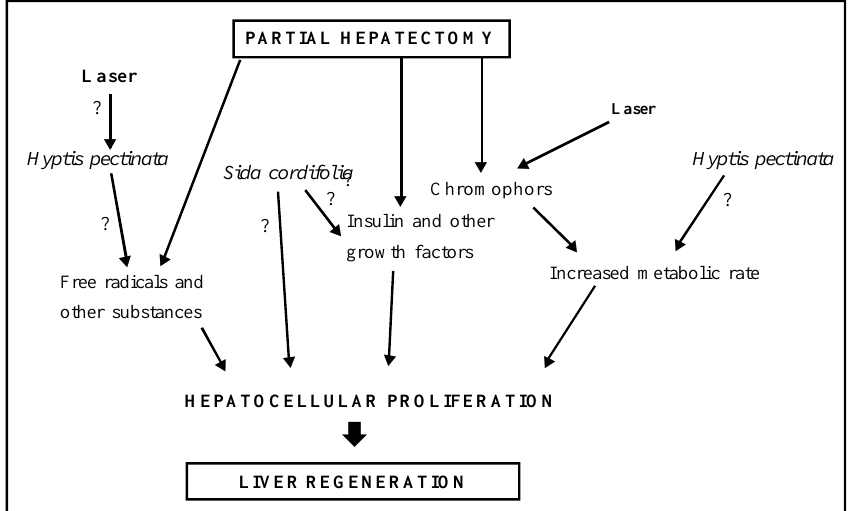
FIGURE 1 : Flow chart disclosing possible and probable interactions of the substances involved in liver